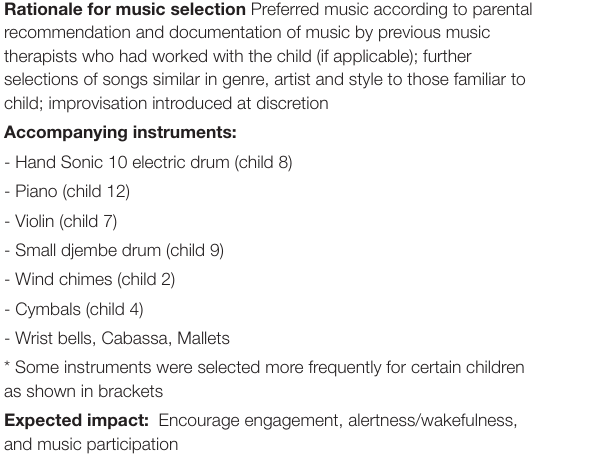
TABLE 3 | Sample intervention